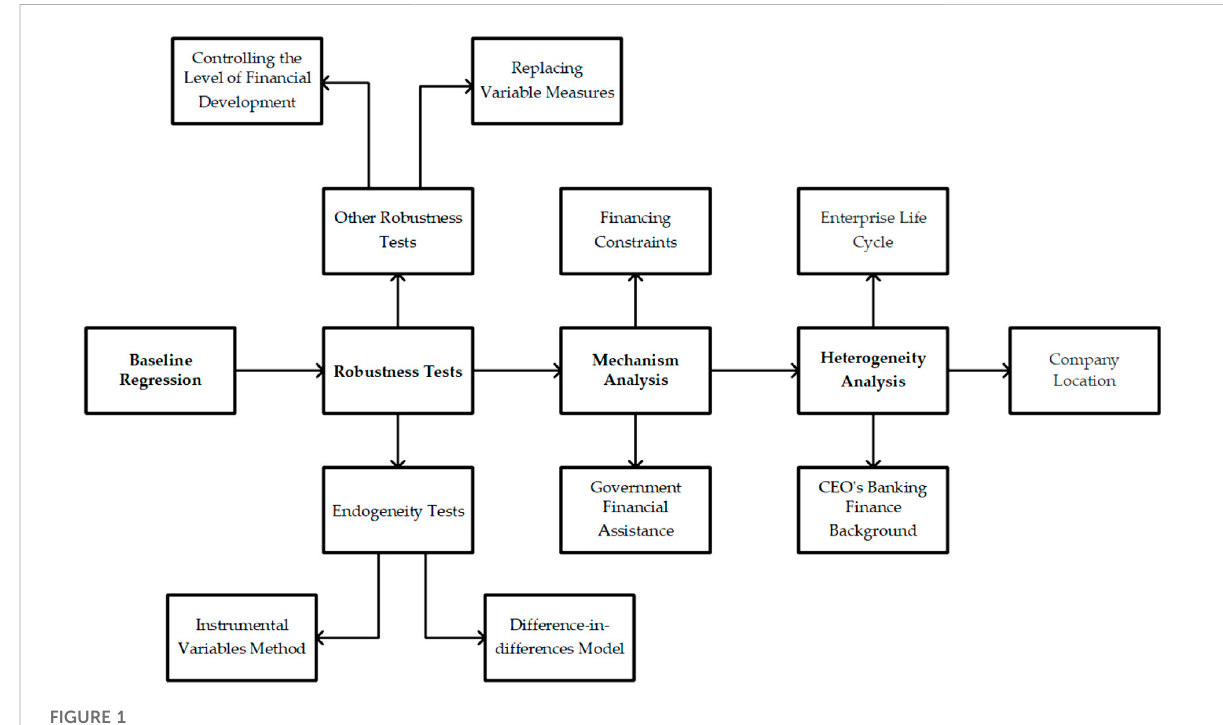
FIGURE 1 Research framework and